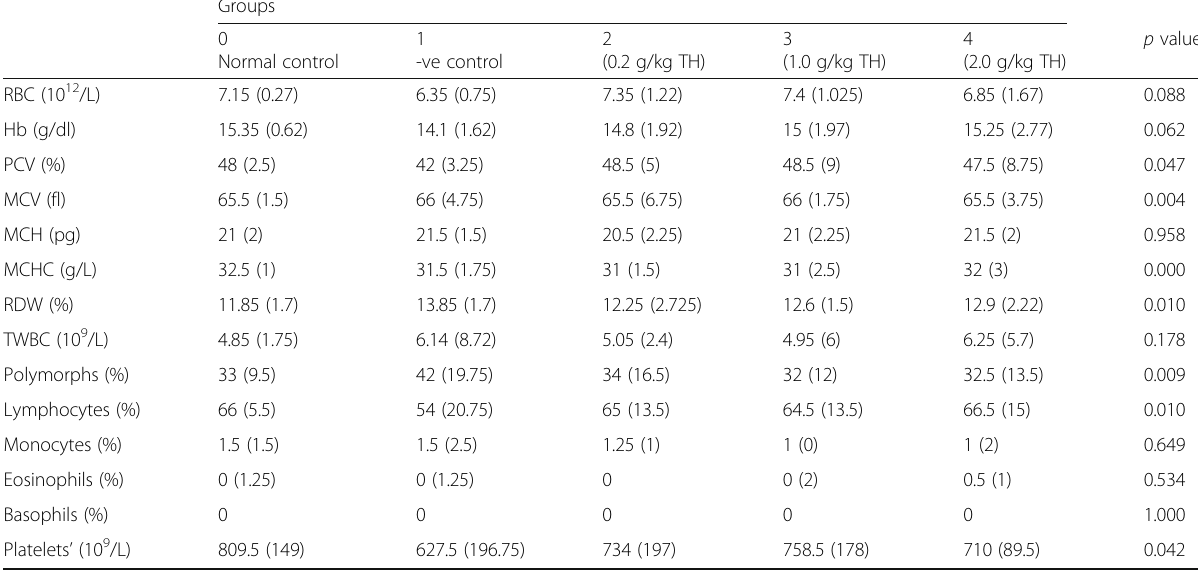
Table 4 The hematological parameters of TH-treated groups compared to controls Groups 0 Normal